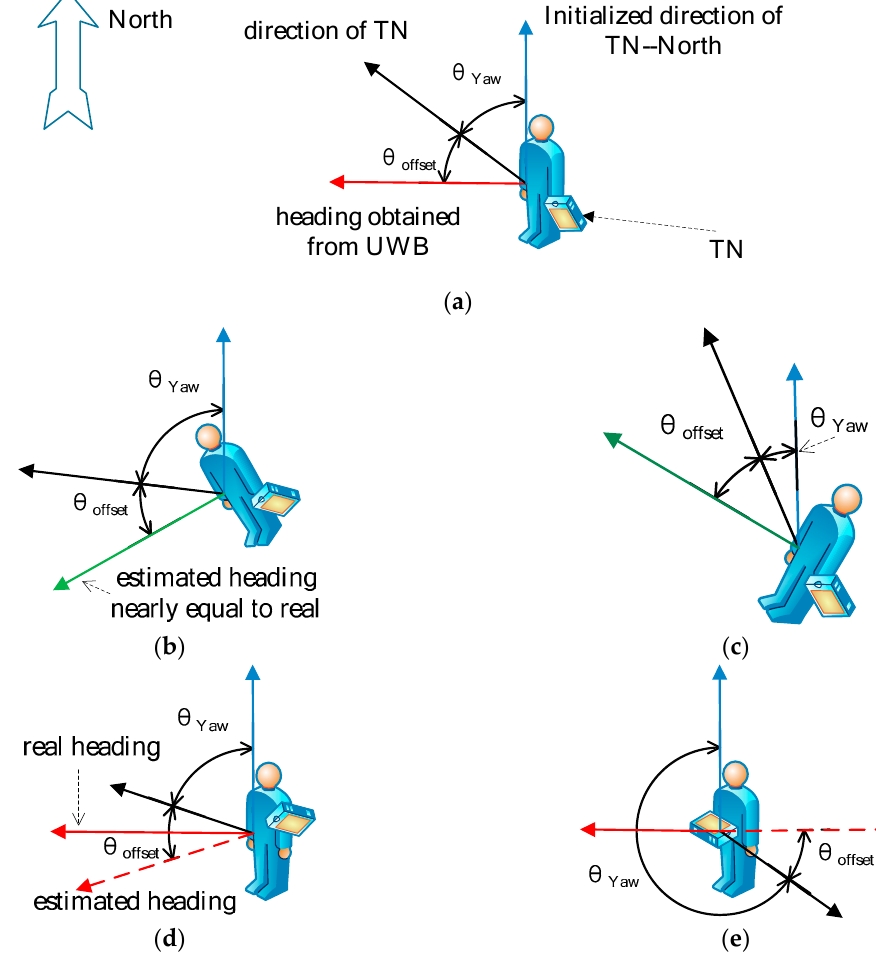
Figure 6. Heading estimation in different situations: ( a ) Obtaining the offset 𝜃 of fset between yaw and heading; ( b , c ) correct heading estimation; ( d , e ) wrong heading estimation.